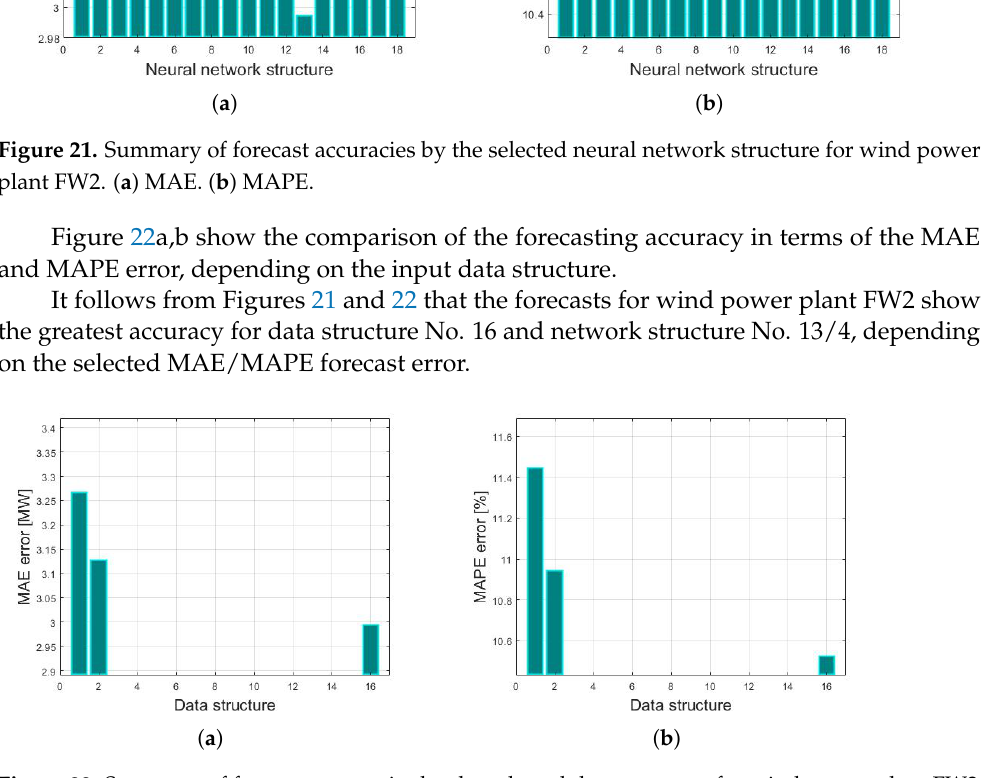
Figure 22. Summary of forecast accuracies by the selected data structure for wind power plant FW2. ( a ) MAE. ( b )